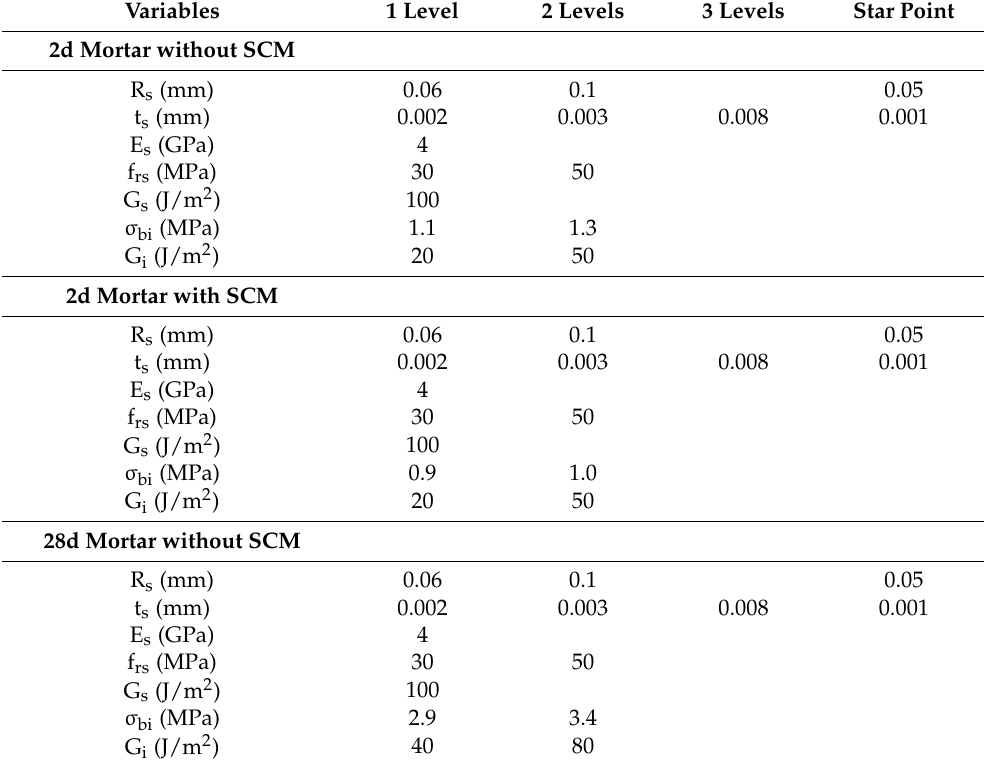
Table 6. Variables considered in the